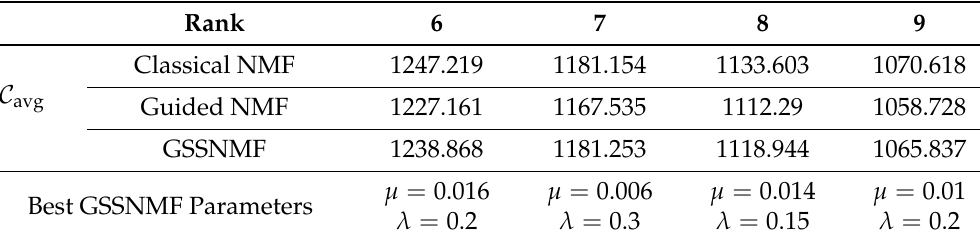
Table 2. Coherence of topics generated by Classical NMF, Guided NMF, and GSSNMF for CIP